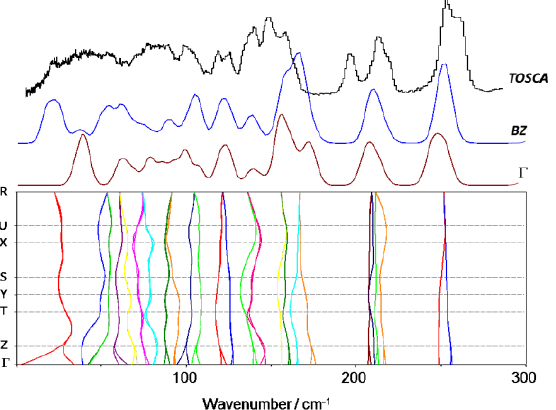
Figure 7. Experimental and calculated (“relaxed cell”) INS spectra of 4EtOB in the range below 300 cm −1 . Bottom panel: calculated phonon dispersion relations along the high symmetry points; top lines: comparison between the INS spectra calculated at the Γ-point (Γ), averaged by the dispersion throughout the Brillouin zone (BZ), and experimental INS spectrum (Tosca).